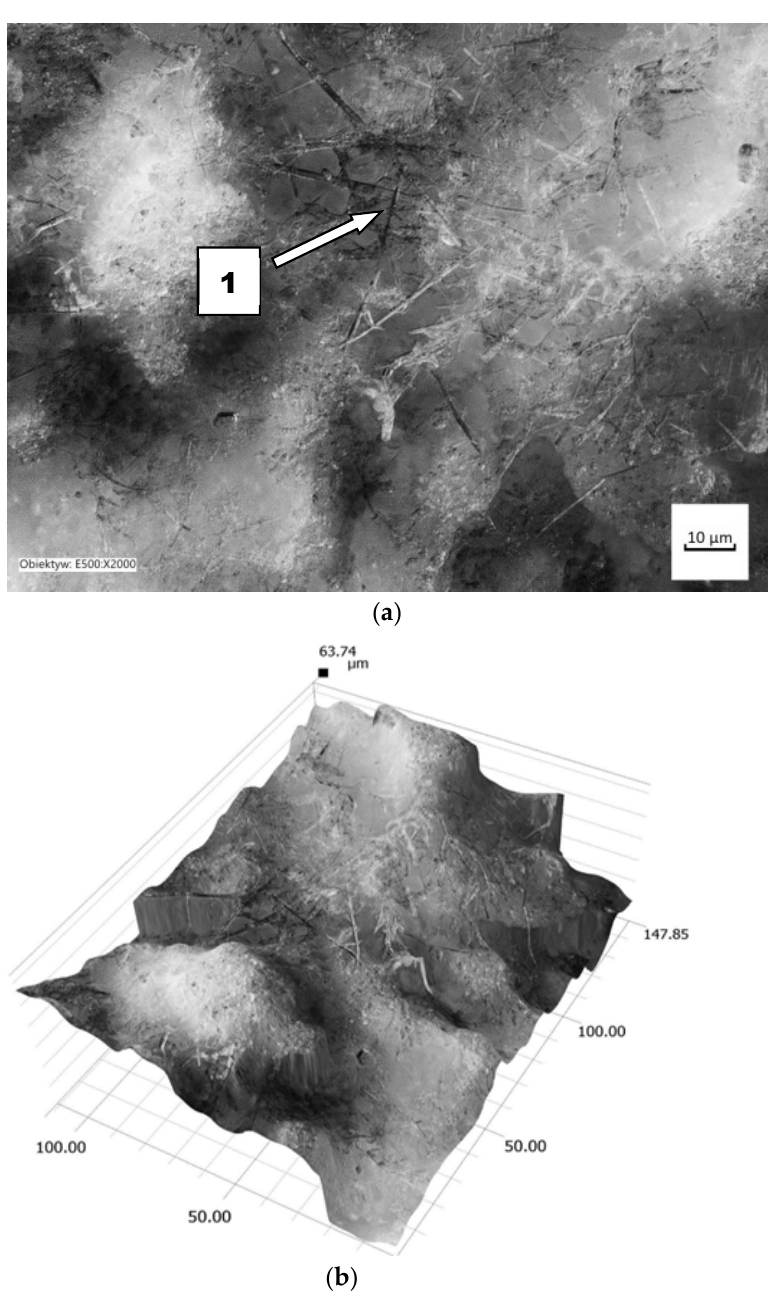
Figure 11. The friction surface condition after wear in light soil: ( a ) scratches and local surface chipping, magnitude 2000×; (1) micro-cutting; ( b ) friction surface profile.